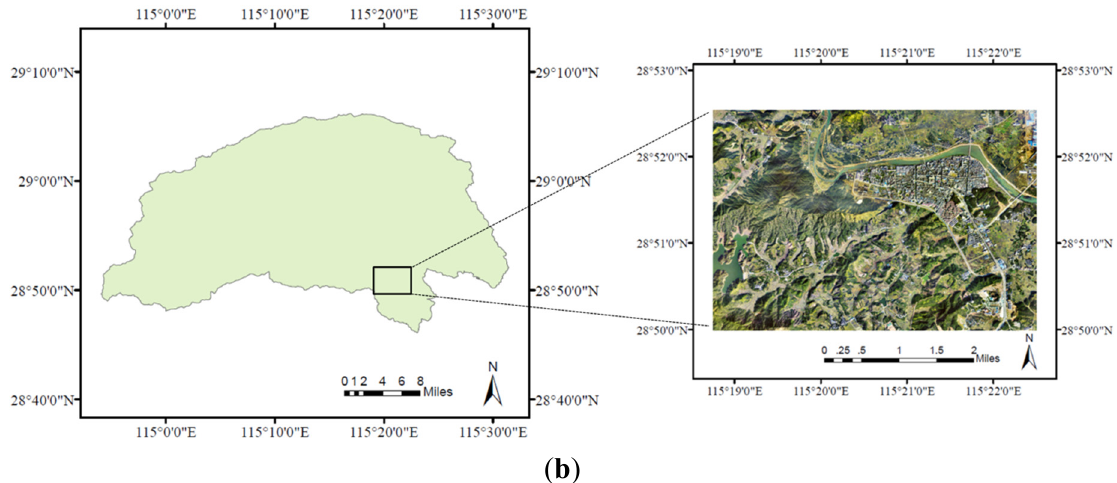
Figure 3. Study areas. ( a ) Chinese provincial administrative region map; ( b ) County 3 and the corresponding remote sensing image of one typical land cover